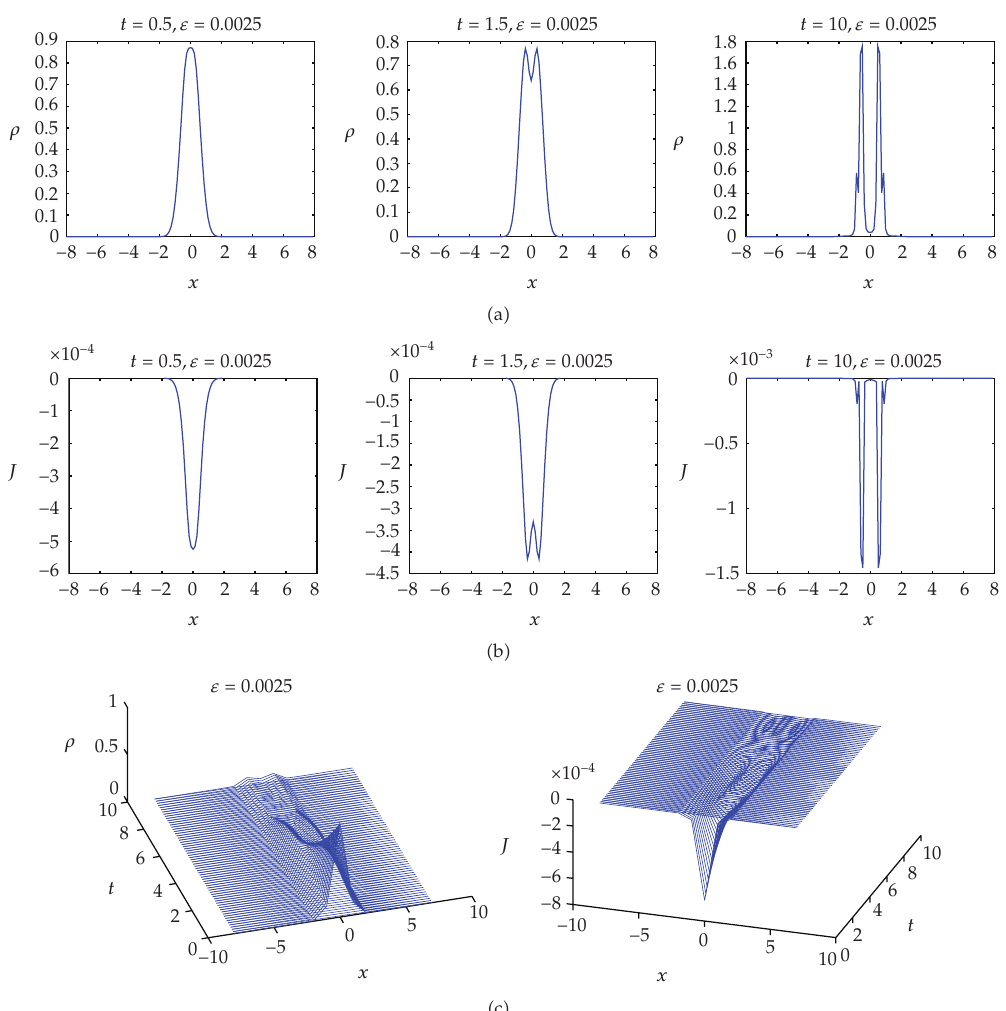
Figure 4: Numerical solutions of Example 5.1 by ED2/EP2 for the weak O (cid:3) ε (cid:4) defocusing nonlinearity (cid:3) ε (cid:6) 0 . 0025 (cid:4)